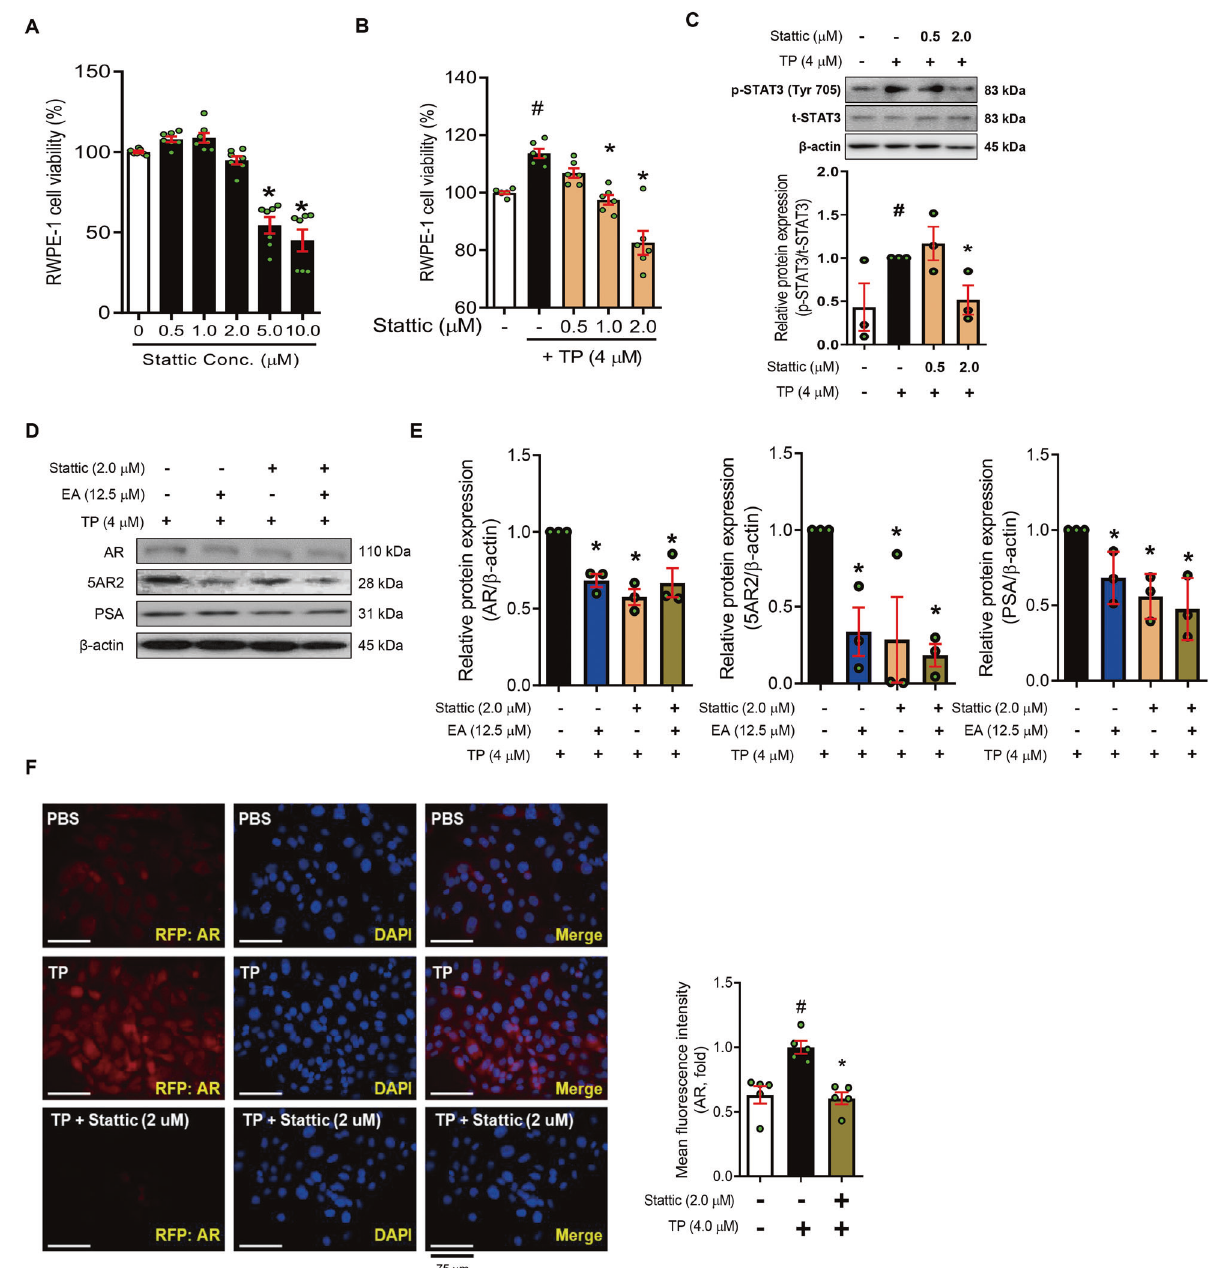
2.0 μ M) treated RWPE-1 cells by Western blot analysis and normalized to t-STAT3. D , E Protein levels of AR, 5AR2, and PSA were analyzed by Western blot analysis. β -actin was used as a loading control. F Protein level of AR was detected using immuno fl uorescence staining. The levels 0.05 vs. PBS-treated RWPE-1 cells, * p < 0.05 vs. TP-treated RWPE-1 cells. PBS phosphate-buffered saline, TP testosterone propionate, EA ellagic